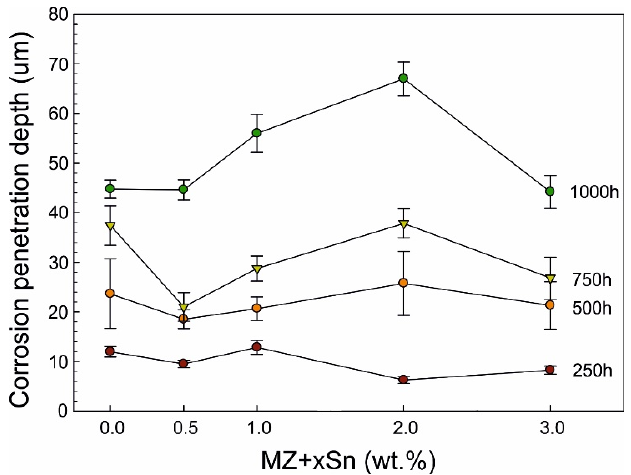
Figure 7. Depth of IG corrosion—annealed samples. SEM investigation of as-cast MZ + 0.0Sn samples after 250 h of NSST revealed a significant portion of the microstructure being affected by the intergranular corrosion reaching as deep as ~50 µ m (Figure 5). This effect is even more pronounced on the as-cast samples with 1–3 wt.% of Sn. IG corrosion can be formed as deep as ~150 µ m for the as-cast MZ + 3.0Sn samples (Figure 5). This effect is further emphasised during longer exposures in the salt spray chamber. The IG corrosion can reach depths of over 370 µ m on average for the as-cast MZ + 2.0Sn and MZ + 3.0Sn samples exposed for 1000 h (Figures 4c and 5). Complex ZnAlMg interdendritic areas were affected preferentially by the IG corrosion (Figure 8).